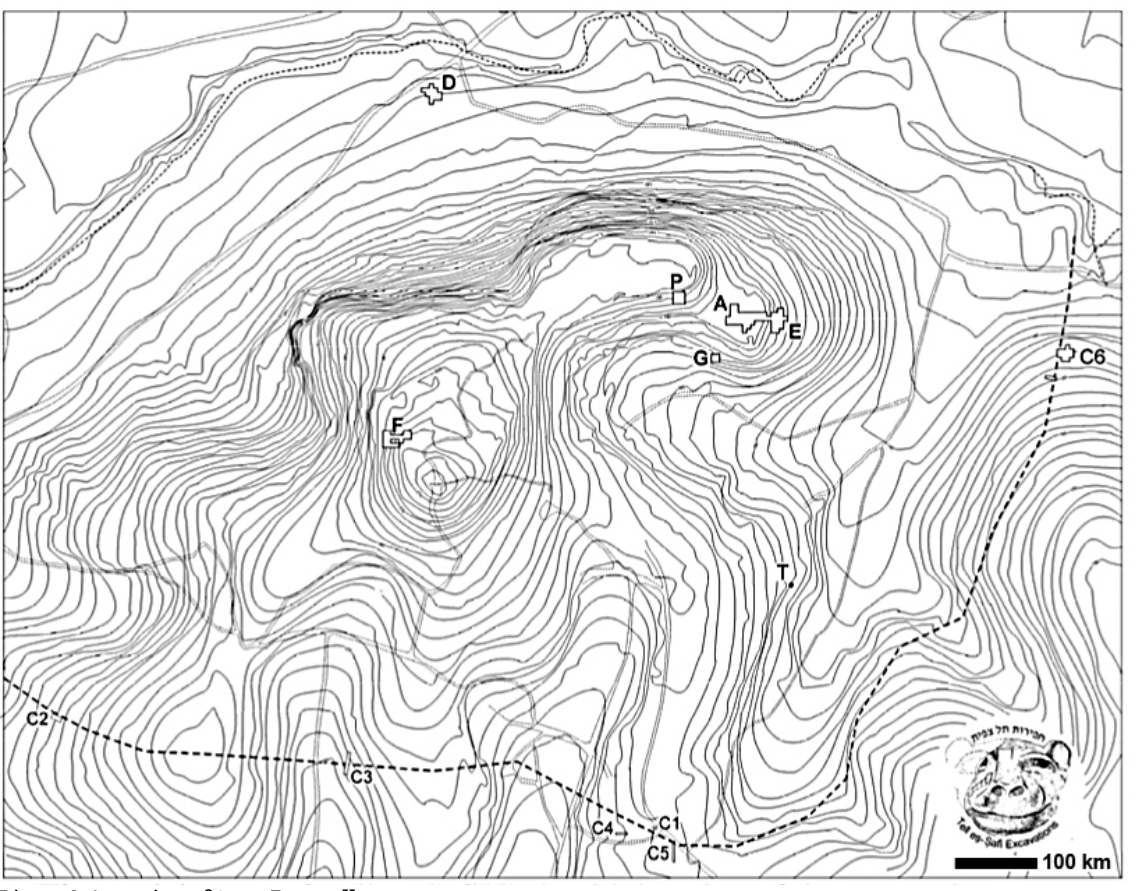
Figure 2. Location of Area E on